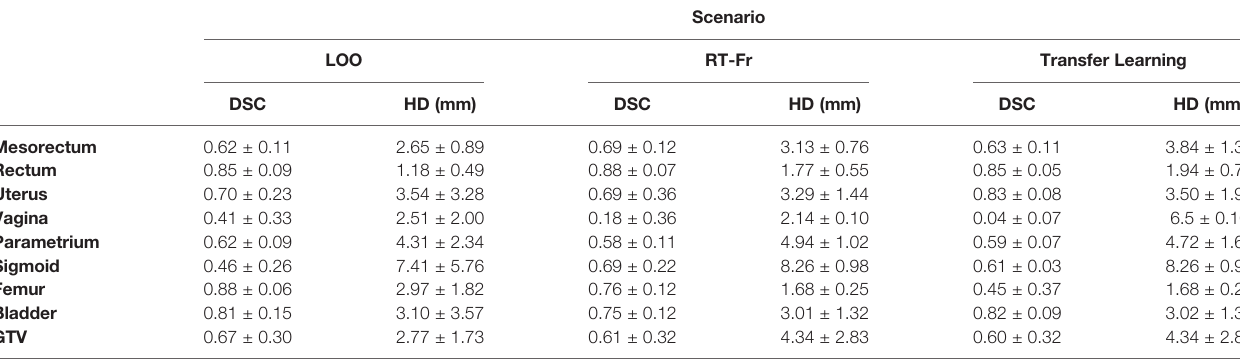
TABLE 1 | Dice Similarity Coef fi cients (DSC) and Hausdorff distances (HD) (mean ± SD) between the manual and network contours for each of the investigated scenarios.